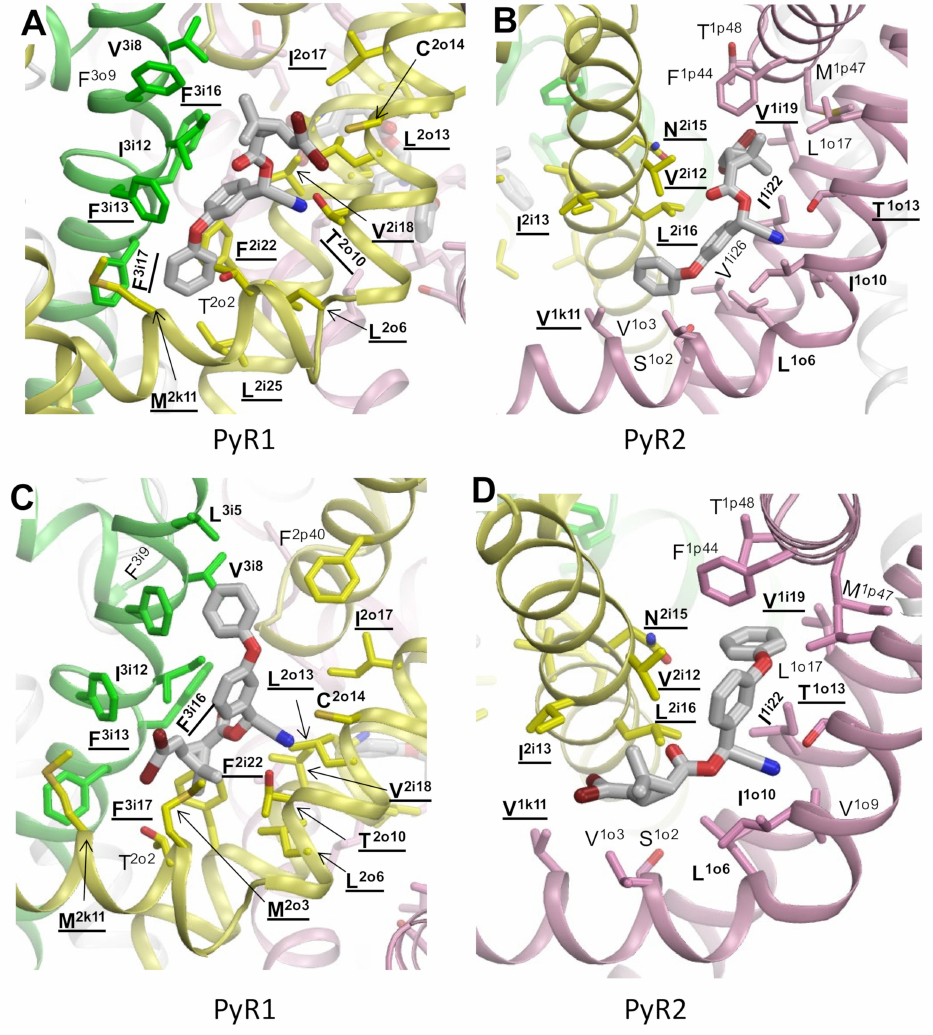
Figure 2. Alternative binding modes of deltamethrin in the PyR1 ( A , B ) and PyR2 ( C , D ) sites of the mosquito sodium channel with an in silico opened pore domain, o AaNav1-1. Side chains of residues within 4 Å from DMT are shown. Labels of residues for which kdr mutations are reported (Table 1) are bold-underlined. Labels of residues for which kdr mutations are unknown, but the engineered mutations that are shown to affect the action of pyrethroids (Table 2) are